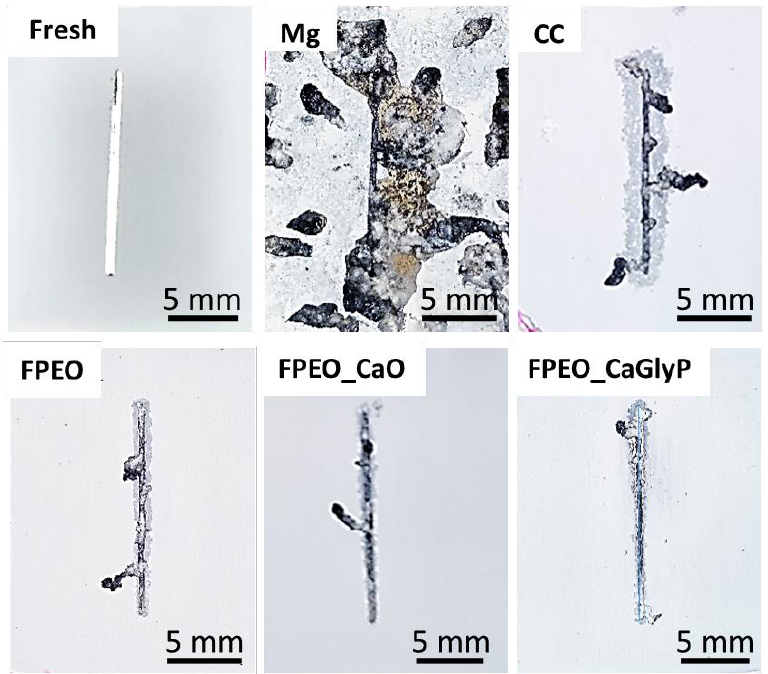
Table 9. Creepage evaluation and the ASTM D 1654 rating of the painted materials following 7 days of exposure to neutral salt spray (NSST).